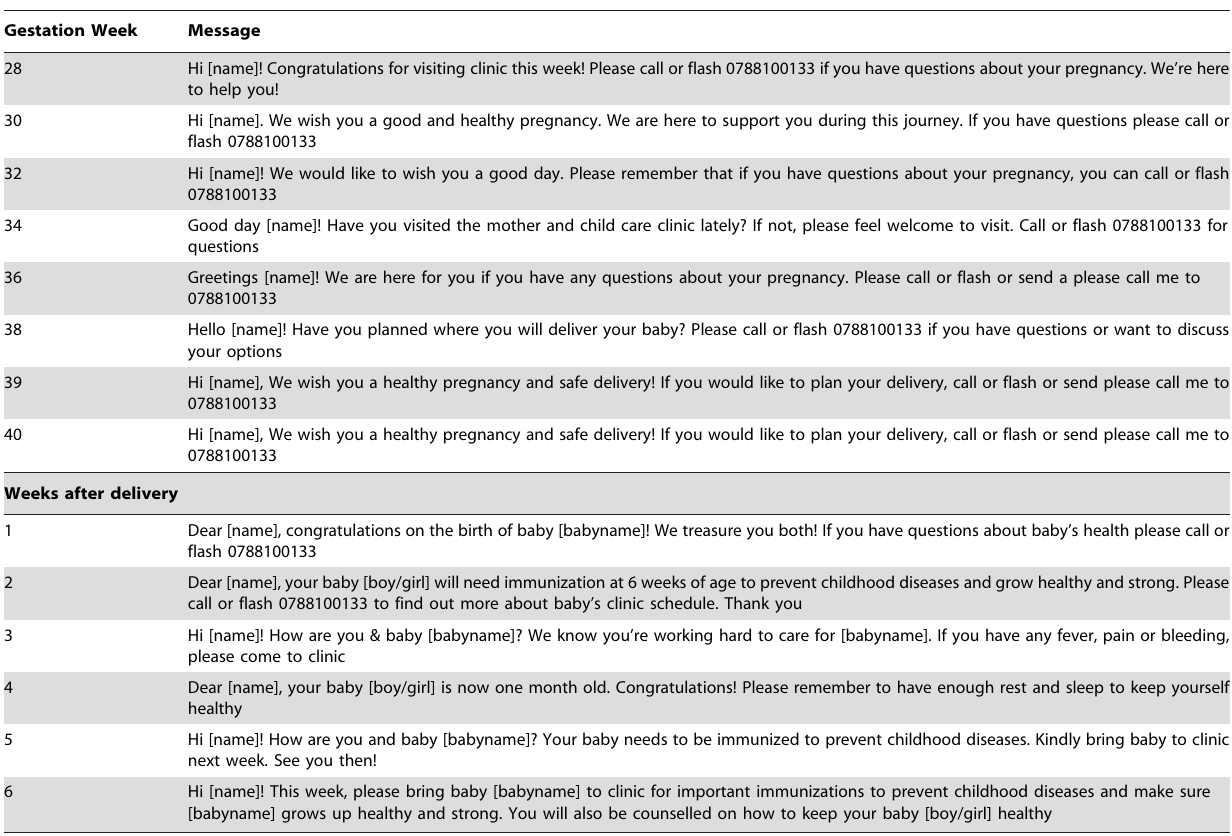
Table 3. Intervention text